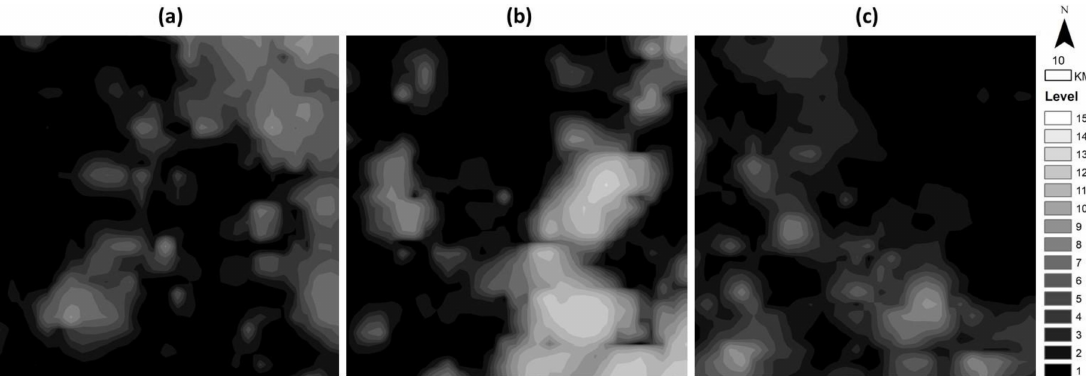
Figure 3. Three cases of deep convolutional generative adversarial network (DCGAN) training images mapped by Tencent positioning big data. ( a ) to ( c ) from Beijing, Nanjing and Shanghai cities on 20:00 p.m. 29 April, 2019, respectively.